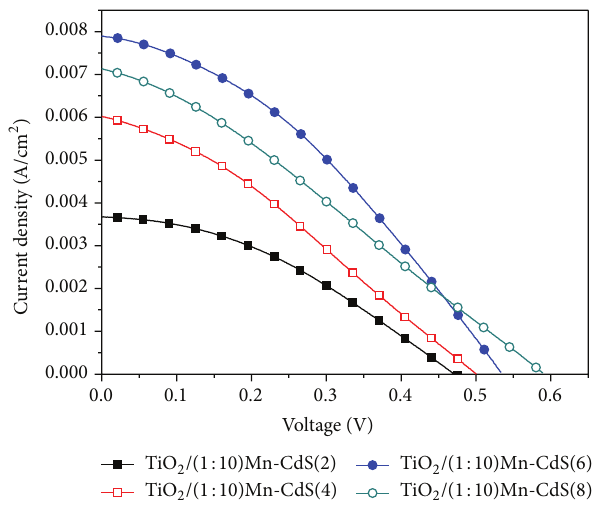
Figure 6: The 𝐽 - 𝑉 characteristics of different sample based on SILAR